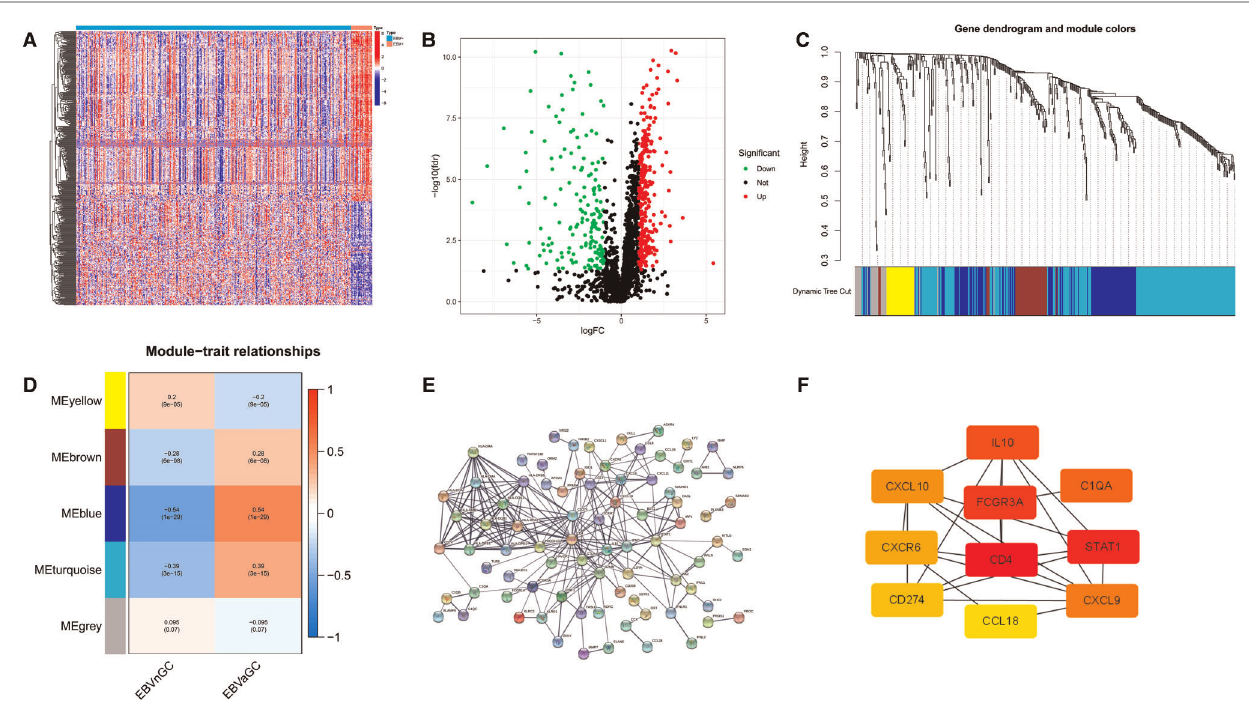
FIGURE 5 | DE-IRGs and HUB genes. ( A ) Heatmap for DE-IRGs among EBVaGC and EBVnGC. ( B ) Volcano plot for DE-IRGs between EBVaGC and EBVnGC. ( C ) Identi fi cation of coexpression modules in EBVaGC. The cluster dendrogram ’ s branches re fl ect the fi ve distinct gene modules. Each module represents a group of corelated genes and has its own color. Each leaf segment on the cluster dendrogram represents a gene. ( D ) Heatmap illustrates the relationship between gene modules and EBVaGC or EBVnGC. ( E ) PPI network of genes in the blue module created by STRING. ( F ) Ten HUB genes identi fi ed by Cytoscape plugin CytoHubba. The color of the nodes re fl ects the degree of connection; red represents a higher degree, while yellow represents a lower degree.